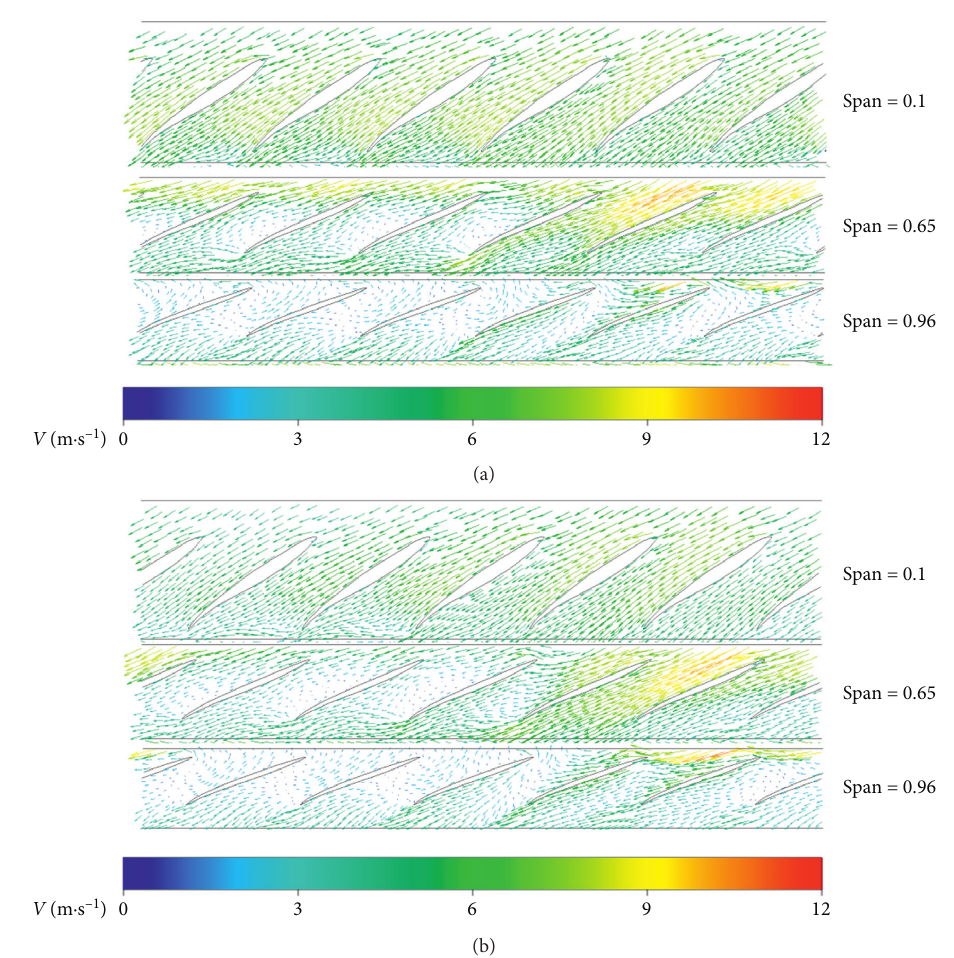
Figure 17: Velocity vector on each span of original scheme and selected scheme under 0.5 Q ′ condition: (a) original scheme; (b) selected